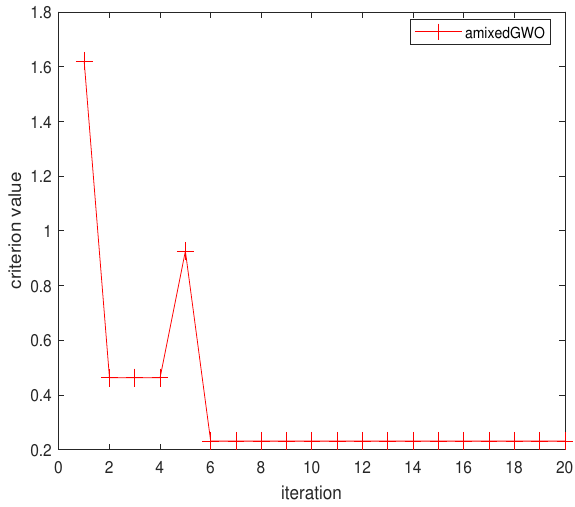
Figure 27. Convergence curve for amixedGWO, with fixed frequency 92